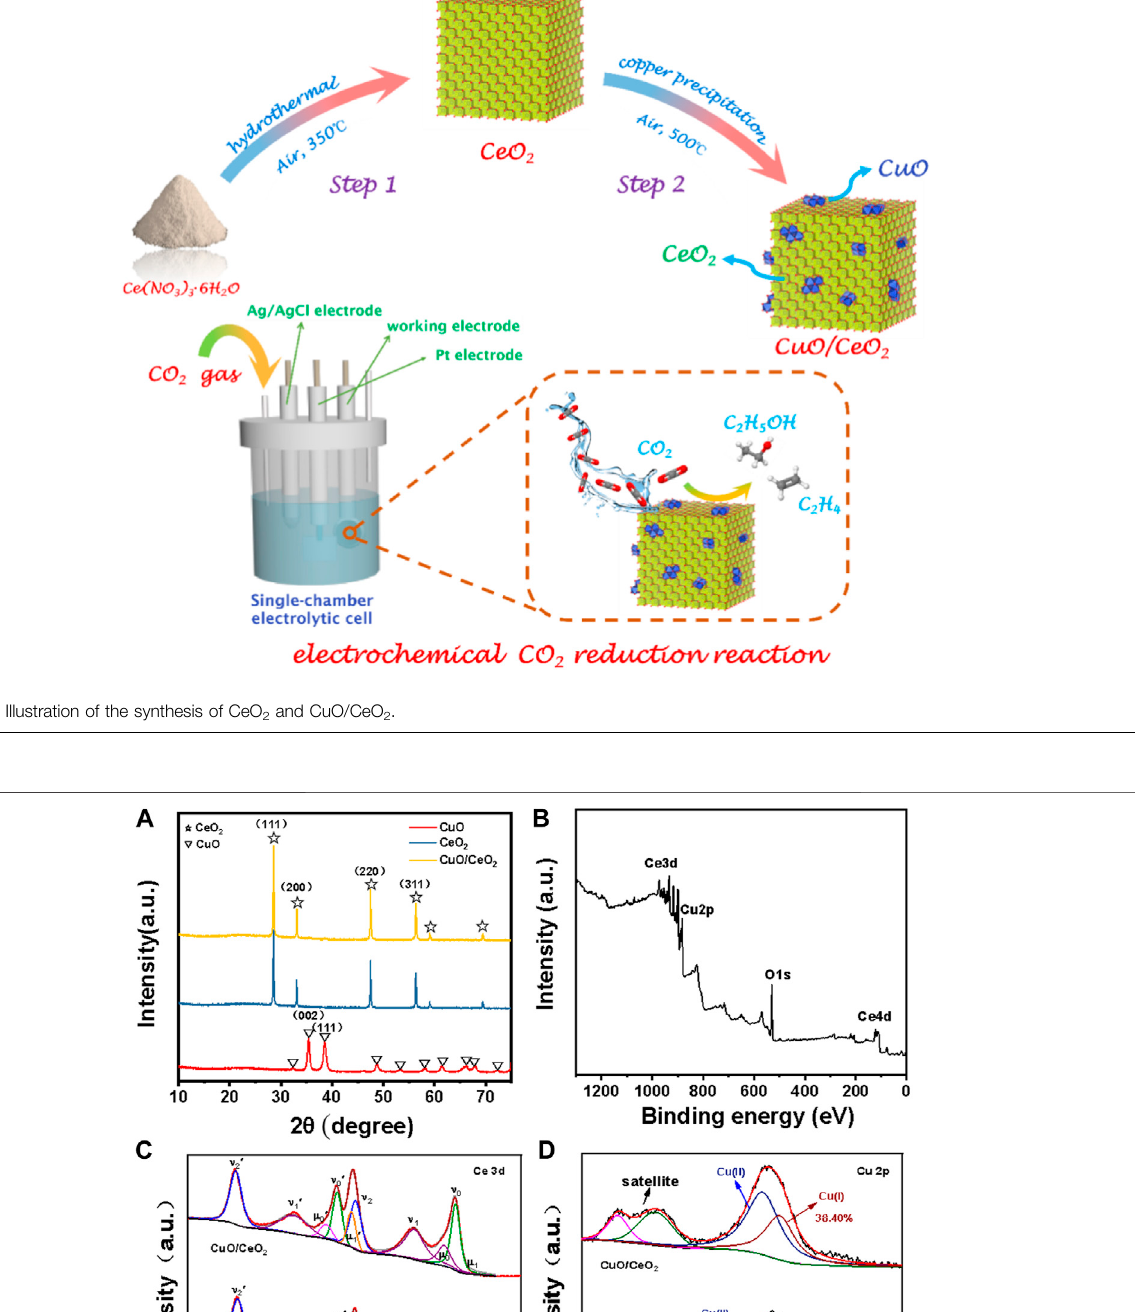
FIGURE 2 | (A) XRD spectra of CuO, CuO/CeO Cu 2p spectra of CuO and CuO/CeO 2 .